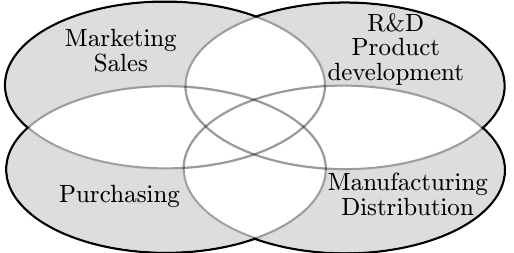
Figure 1: Functions and departments conceived as process focused collaborative units (Ericsson 1996,